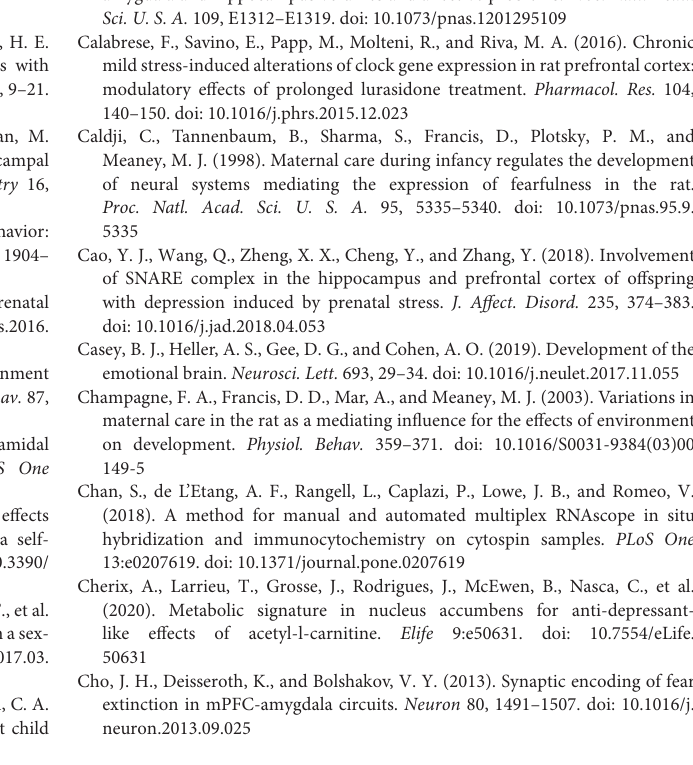
information: symbols represent individual data. Error bars indicate mean ± SEM. ( B ) Total fluid intake during the sucrose preference test. Two-way ANOVA analysis revealed a significant effect of sex [ F (1, 78) = 44.49, p < 0.0001]. For direct comparison of two groups: ∗∗∗ p < 0.001, ∗∗∗∗ p < 0.0.001 Bonferroni’s multiple-comparison test. Symbols represent individual data. Error bars indicate mean ± SEM. Supplementary Figure 4 | Analysis of maternal care behavior. (A) Number of events of maternal behavior of control and stressed dams. The total of all behavioral categories examined over the first 15 days postnatally is graphed. Data information: symbols represent individual data. Error bars indicate mean ± SEM. Two-way ANOVA revealed no significant effect of type of stress [ F (1, 111) = 0.003767, p = 0.9512]. (B) The graph shows the frequency of pups-directed behavior, including dams building the nest, in the nest nursing in any position, licking pups, contact with pups, retrieving the pups or no interaction with pups versus self-directed behavior, involving eating/drinking, self-grooming, off or exit from the nest, from a total of 200 observations per mother (40 observations per mother per day). Data information: symbols represent individual data. Error bars indicate mean ± SEM. Two-way ANOVA revealed a significant effect of type of behavior F (9, 180) = 68.68, p < 0.0001. For direct comparison of two groups: ∗∗∗ p < 0.001. (Bonferroni’s multiple-comparison test). Supplementary Figure 5 | Analysis of locomotor activity of prenatally stressed adult rats in the open field test. (A) Total distance traveled across 5-min period in the arena was measured. Two-way ANOVA analysis revealed significant effects of sex [ F (1, 78) = 20.40, p < 0.0001]. ( B ) Latency to enter the center of the arena was scored. (C) The number of entries in the center of the arena is shown. Two-way ANOVA analysis revealed significant effects of sex [ F (1, 79) = 8.289, p = 0.0051]. (D) The number of entries in the periphery of the arena is shown. Two-way ANOVA analysis revealed significant effects of sex [ F (1, 80) = 8.306, p = 0.0051] (E) Cumulative time spent in the center of the open field across 5-min time is shown. (F) Cumulative time spent in the periphery of the open field across 5-min time was measured. Data information: symbols represent individual data. Error bars indicate mean ± SEM. For direct comparison of two groups: ∗ p < 0.05, ∗∗∗ p < 0.001, Bonferroni’s multiple-comparison